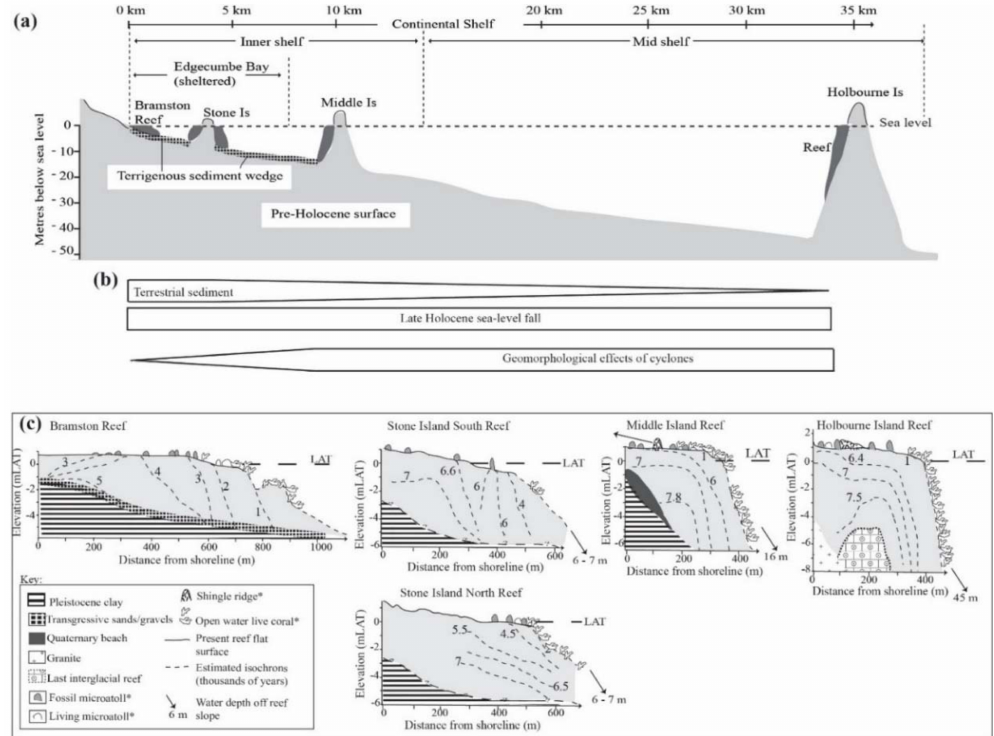
Figure 3. Schematic diagrams showing ( a ) the cross-section through the inner- and mid-shelf Great Barrier Reef extending seaward from the coast at Edgecumbe Bay; ( b ) the cross-shelf relative influence of environmental parameters; and ( c ) scaled conceptual reef growth models for each site based on the chronostratigraphies presented in [39,44–46]. Elevations are relative to lowest astronomical tide (LAT). In the key, * denotes where features are not to